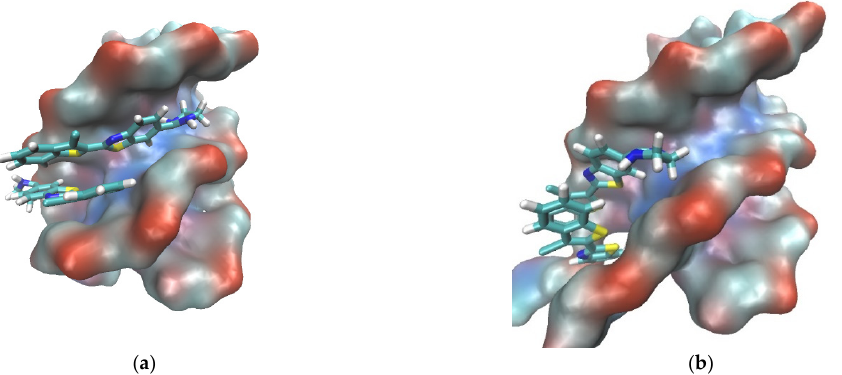
Figure 10. A complex between ATT (DNA triplex) and dimer of 6 obtained after 200 ns of MD simulation in water. ATT is represented by its solvent accessible surface and ligand is given in stick representation. (complexes were built in PyMOL, wherein the initial position of ligands was determined from spectroscopic data. Parametrization was performed by ANTECHAMBER [67] and Leap, the modules available within AMBER16 suite of programs [68,69] using GAFF [70] for the ligands and ( a ) bsc1 [41] and ( b ) OL15 [69] for ATT. Neutralized and solvated complexes were minimized, equilibrated, and simulated for 200 ns using the programs sander and